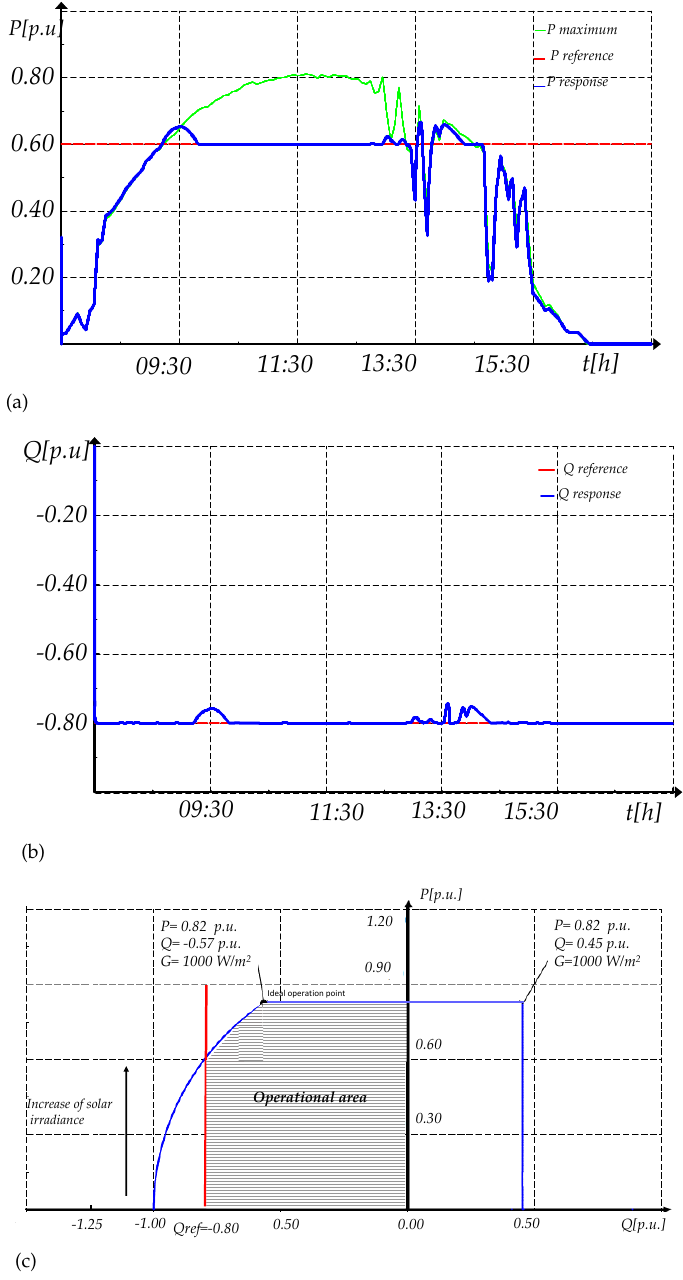
Figure 27. QPPT response when a reactive power reference is applied ( a ) Active power, ( b ) Reactive power, and ( c ) Operational